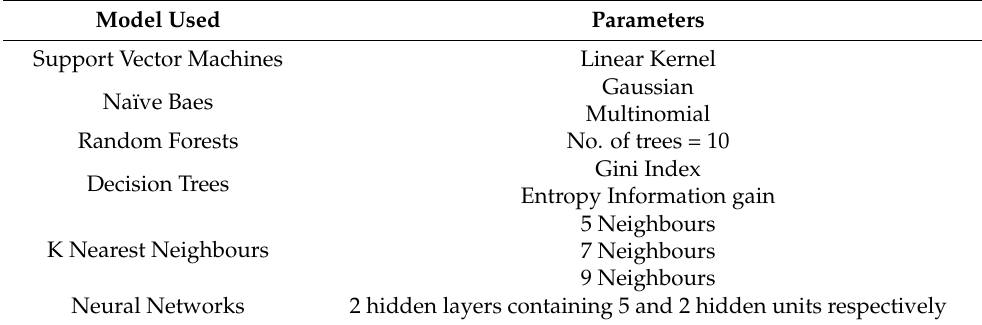
Table 3. List of models used for experimentation.